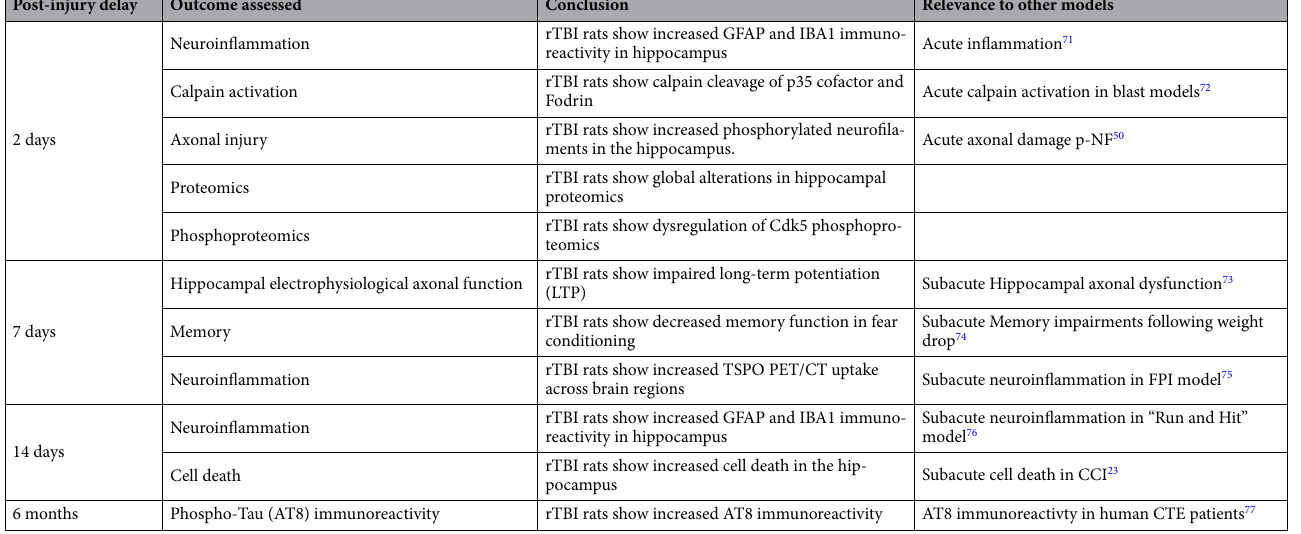
Table 1. Summary of